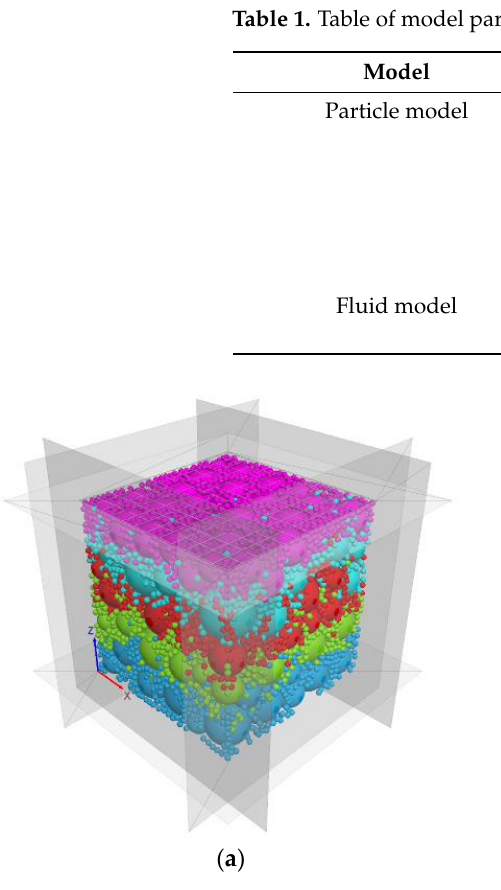
Figure 3. Numerical model of particle flow: ( a ) gradation sample, ( b ) fluid elements, and measure- ment regions. ment